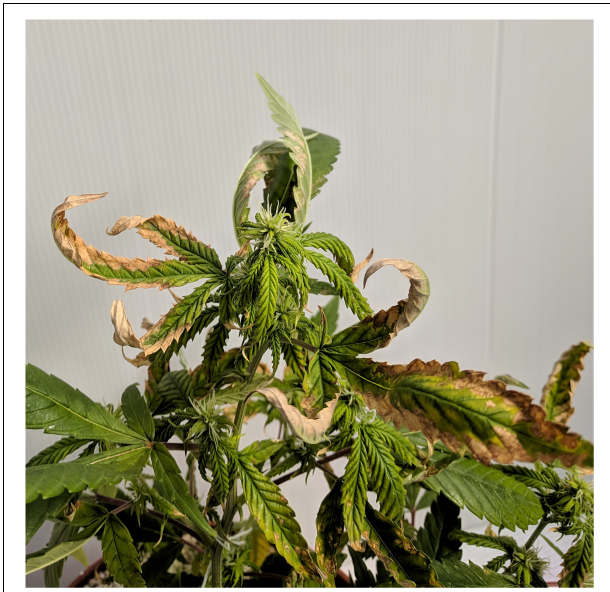
FIGURE 2 | Early symptoms of NH 4 toxicity in medical cannabis. The image was taken 17 days after the initiation of the NH 4 /NO 3 fertigation treatments, showing the apical part of a plant receiving a 100% N-NH 4 regime.